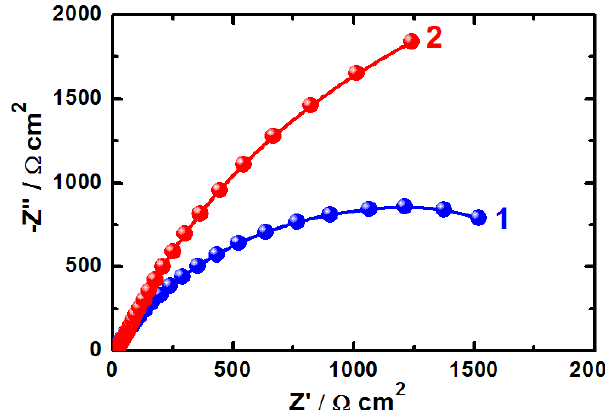
Figure 7. EIS Nyquist plots for (1) pure iron and (2) API X-65 steel at corrosion potential after 12 h immersion in 4.0 wt % NaCl